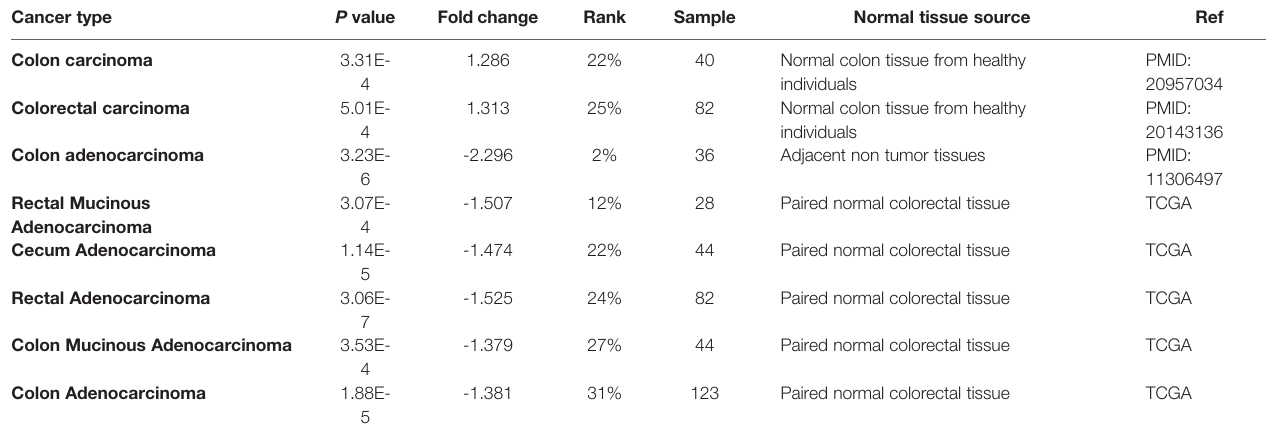
TABLE 1 | ILK mRNA expression in Oncomine CRC datasets comparing levels in normal tissues from either adjacent non tumor tissue or tissues from healthy individuals. Cancer